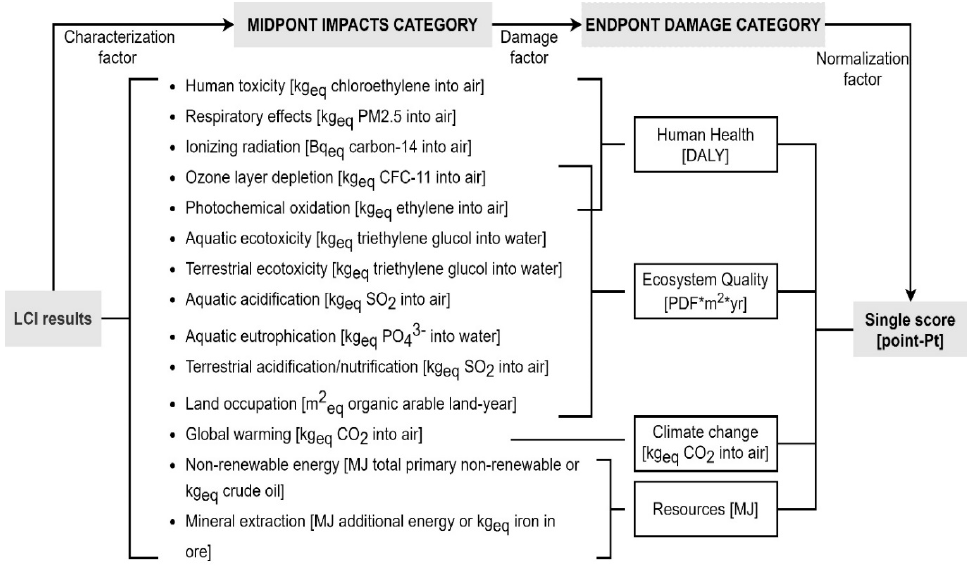
Figure 8. Scheme of the IMPACT 2002+ framework, emission from [59]. Table 6. Normalization factors for the four damage categories for Western Europe version 1.0 [59] .